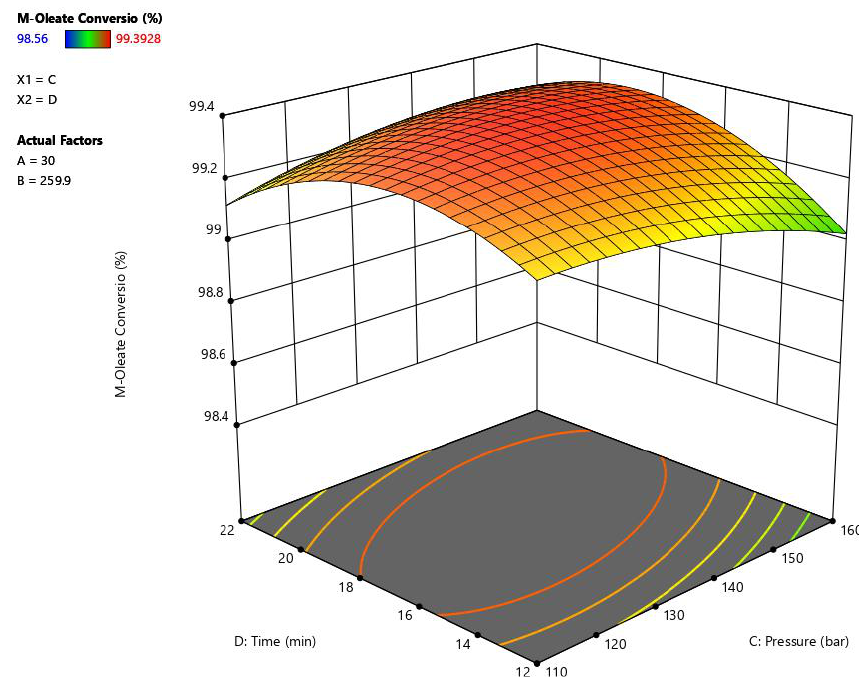
Table 6. Experimental design variables and their coded levels.